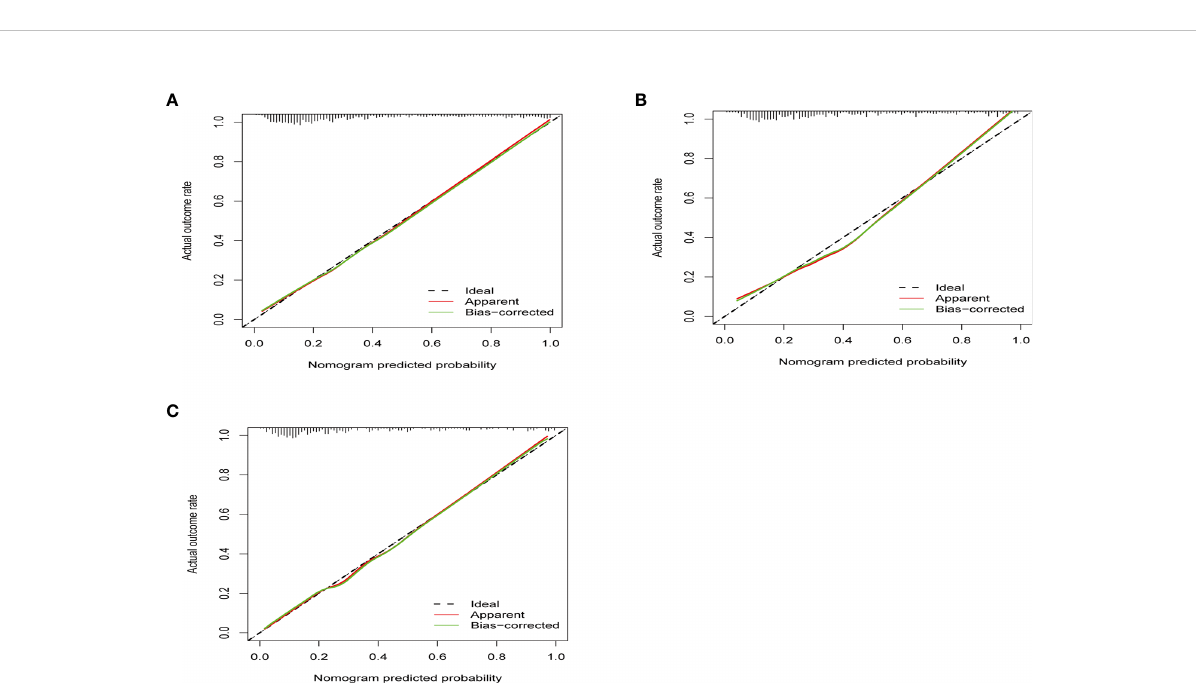
FIGURE 3 The calibration curves show how close the predicted probability of the model was to the actual, observed probability. (A) The calibration curve of training set ( p = 0.801). (B) The calibration curve of internal validation ( p = 0.302). (C) The calibration curve of external validation ( p = 0.335). x-Axis is the model-predicted probability; y-axis is the actual, observed probability. The black line represents an ideal prediction that the predicted risk was exactly the observed risk. The red line represents the model performance, and the closer the red line was to the ideal line, the better the prediction of the prediction model